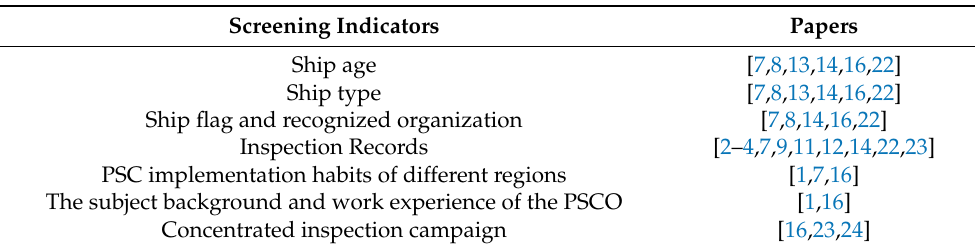
Table 4. Papers summary of relevant PSCO selection of inspected